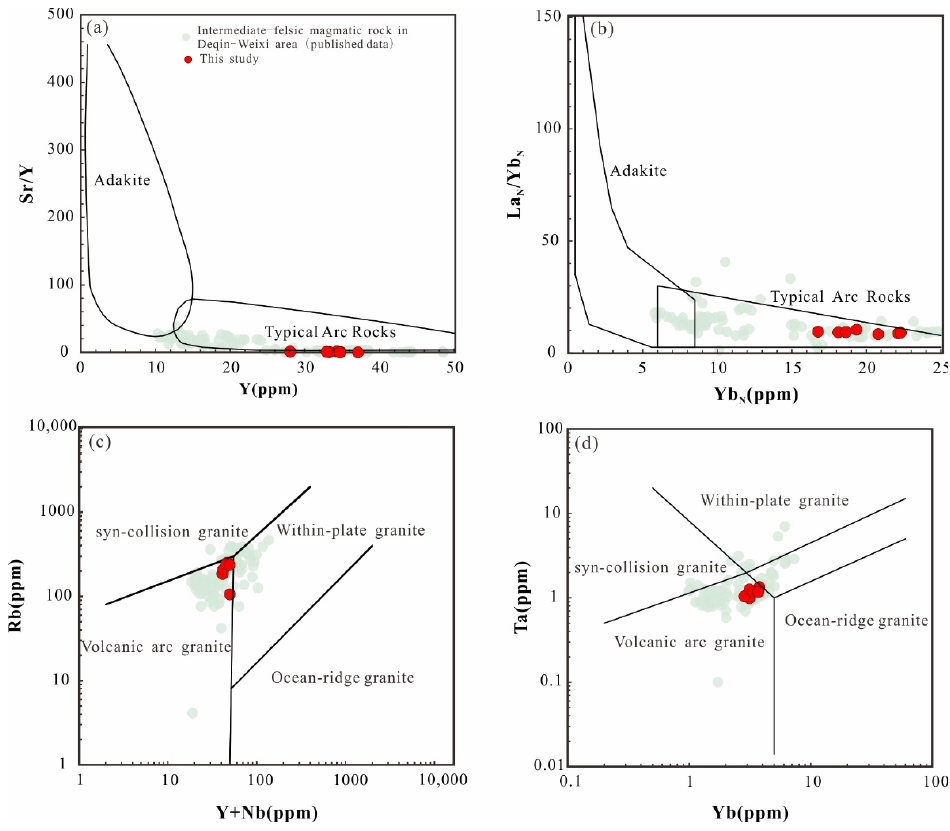
Figure 13. Tectonic discrimination plots for the Madeng dacite: ( a ) Y vs. Sr/Y [65]; ( b ) Yb N vs. La N /Yb N [66] (N-Chondrite normalized [44]); ( c ) Y + Nb vs. Rb [67]; ( d ) Yb vs. Ta [67]. Data source: [8,10–12,15,43].